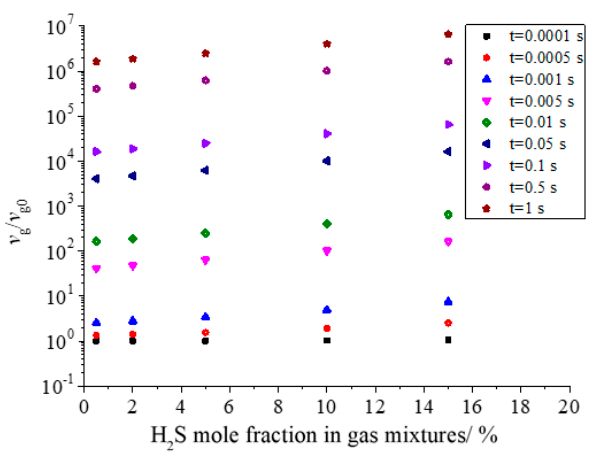
Figure 18. Effect of H 2 S concentration on dimensionless geometric volume.